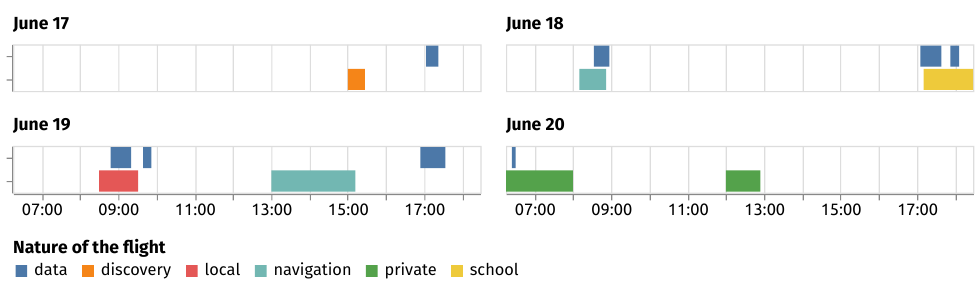
Figure 3. Comparison of detected activity based on Mode A/C data with flight logs for a private aircraft based at Eyguières airfield LFNE nearby our LFMY receiver. In spite of no ADS-B-compliant equipment, it is possible to detect a local activity of the aircraft. Figure 4 reflects the difference in philosophy between ADS-B and FLARM technologies: